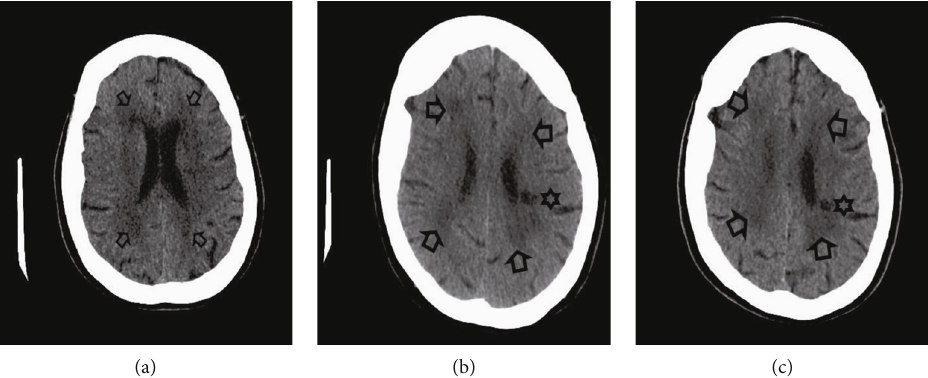
Figure 1: Axial noncontrast computed tomography of the head from 2017 to 2019 ((a) May 2017, (b) August 2018, and (c) October 2019). Key: arrow=hypoattenuation in the deep white matter is in keeping with moderate chronic small vessel ischaemic disease. Appearances are stable from 2017 to 2019. Star =chronic lacunar infarct in the left parietal lobe ( fi rst visualised in